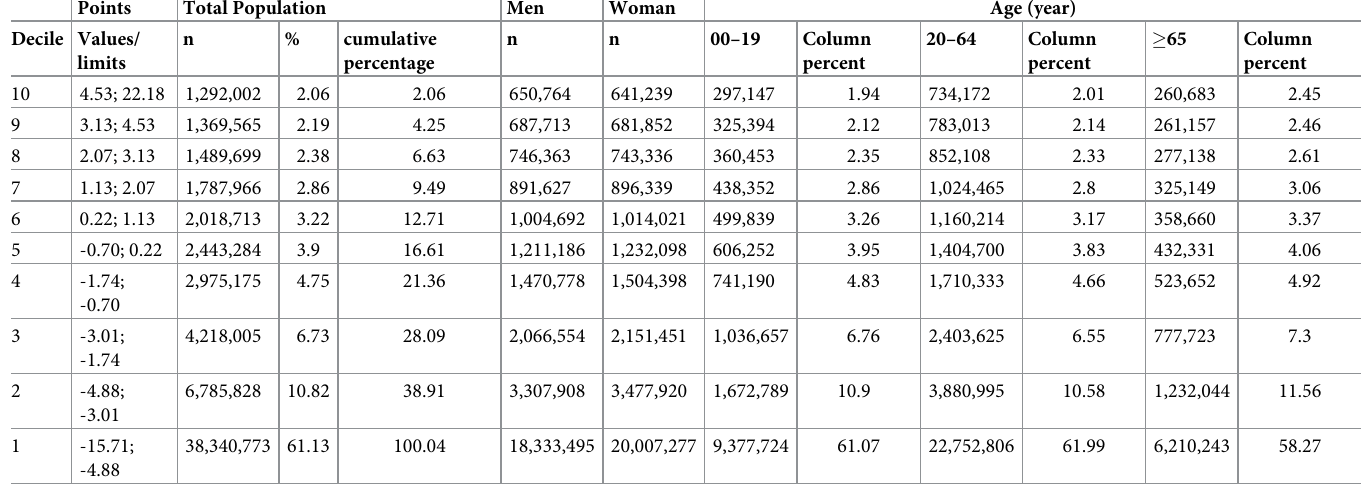
Table 1. Distribution of accessibility